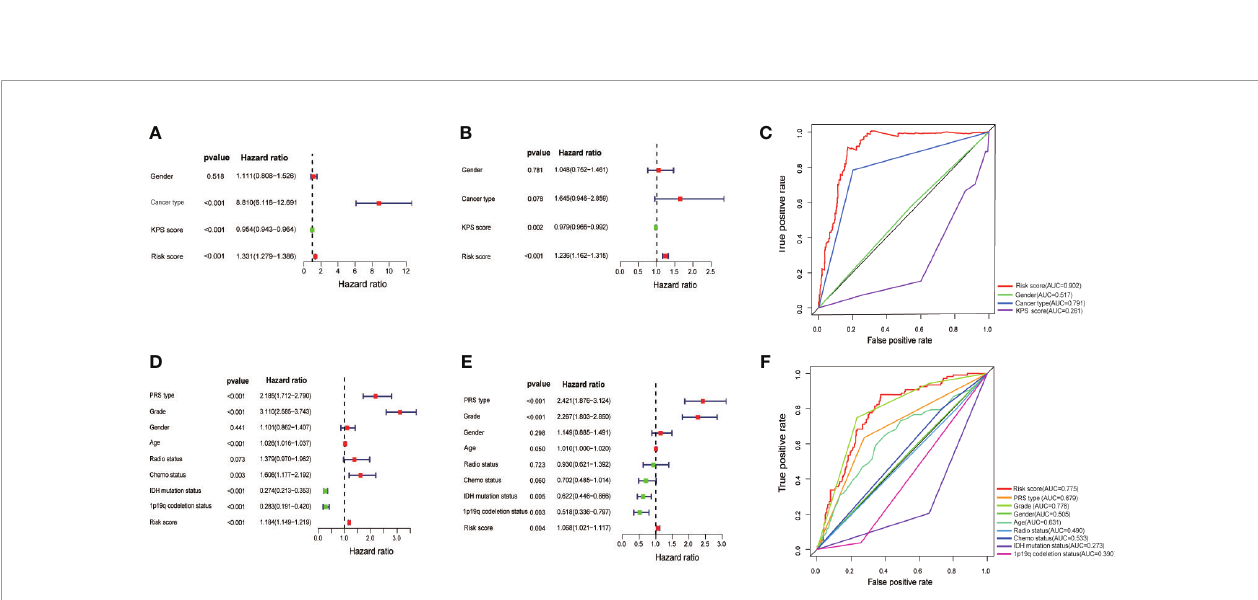
FIGURE 4 | Kaplan-Meier survival and ROC curve analysis in the TCGA and CGGA data sets. (A) Kaplan-Meier survival analysis based on 10 MES-related lncRNAs between the high- and low-risk groups in TCGA testing set. (B) Kaplan-Meier survival curve for CGGA independent validation set. (C) ROC curve shows the performance of the prognostic models in predicting OS of glioma patients from TCGA testing set. (D) ROC curve analysis for CGGA independent validation set.